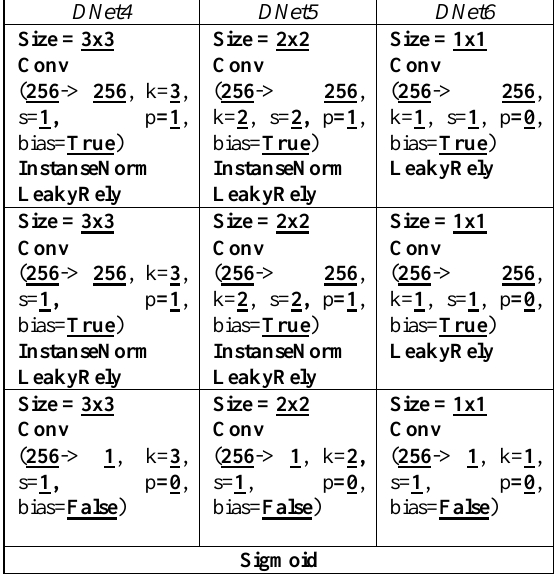
Table 3. Discriminator CNN